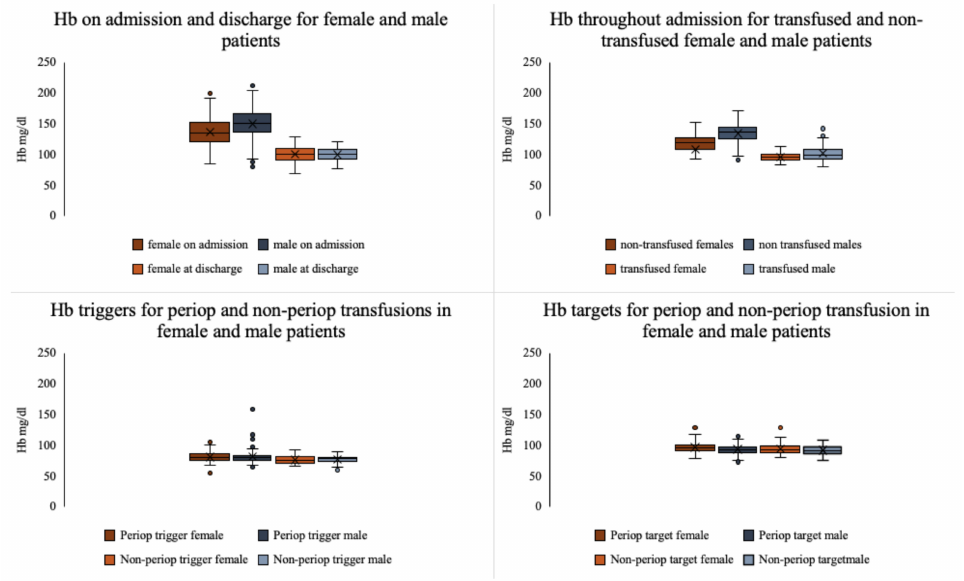
Figure 3. Comparison of haemoglobin values throughout admission, and transfusion triggers and targets for female and male patients.